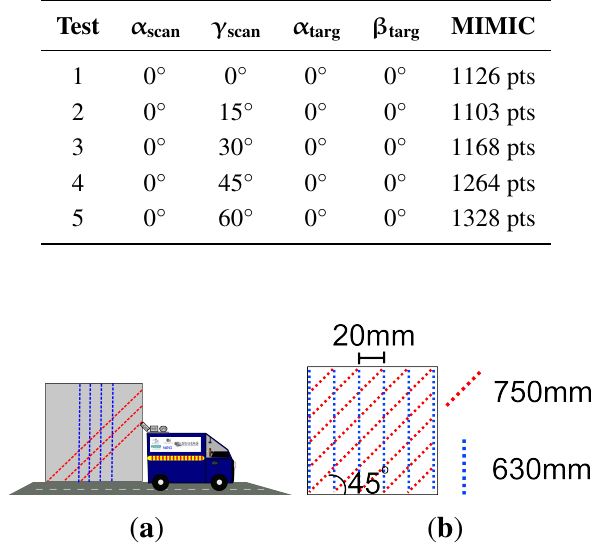
Figure 5. The influence of scanner orientation on point and profile distribution: ( a ) overview of scenario, ( b ) change in vertical inclination of the scanner results in an increase in the length of profile intersecting the